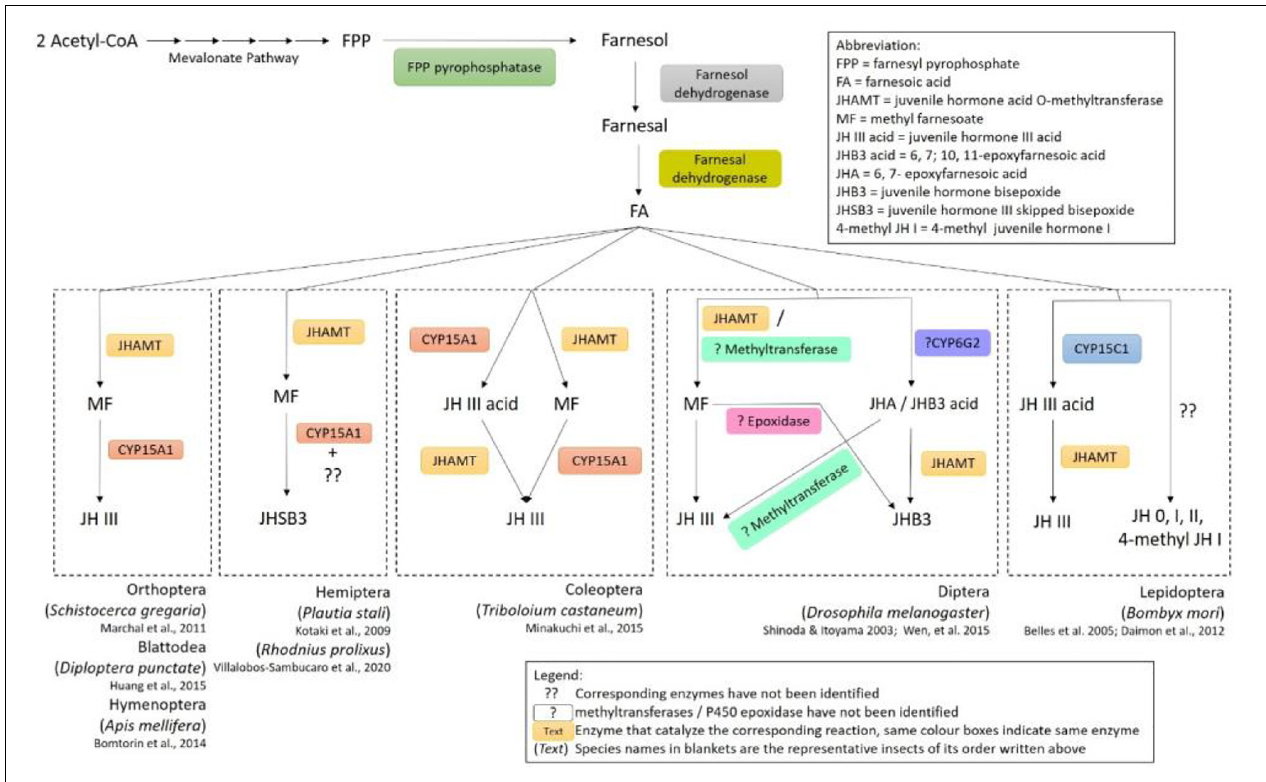
FIGURE 1 | Diverse biosynthetic pathways of juvenile hormones in insects.